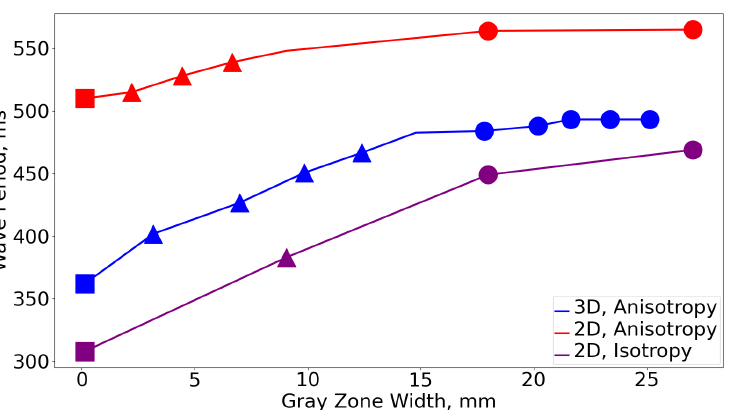
Figure 8. Comparison of dependencies of the wave period on the gray zone width in 3D anatomical model (blue line) and 2D tissue simulations (isotropic case, purple line; anisotropic case, red line). The perimeter of the infarction scar in all models is 162 mm. A triangle indicates gray zone rotation , a square indicates scar rotation , and a circle indicates scar rotation two .